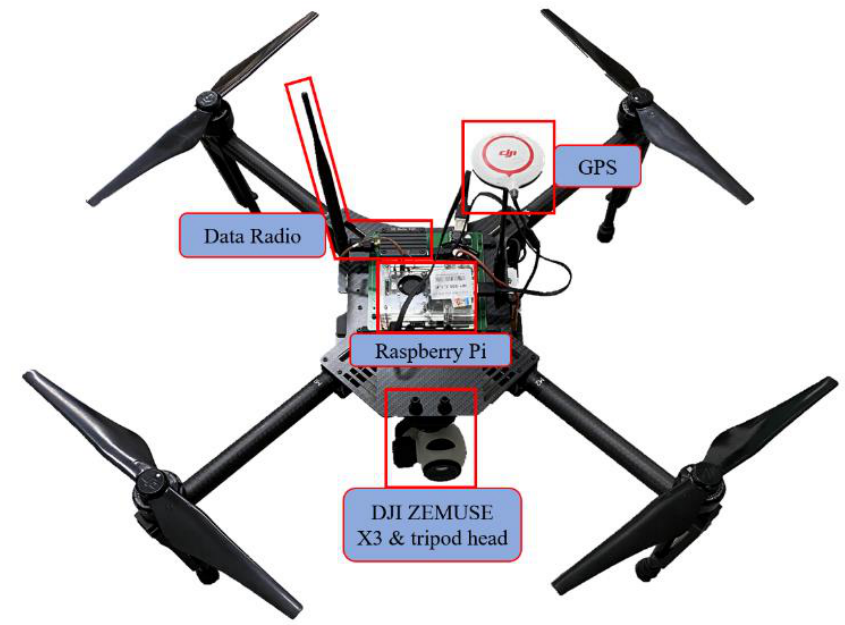
Figure 7. DJI Matrice 100 UAV platform.